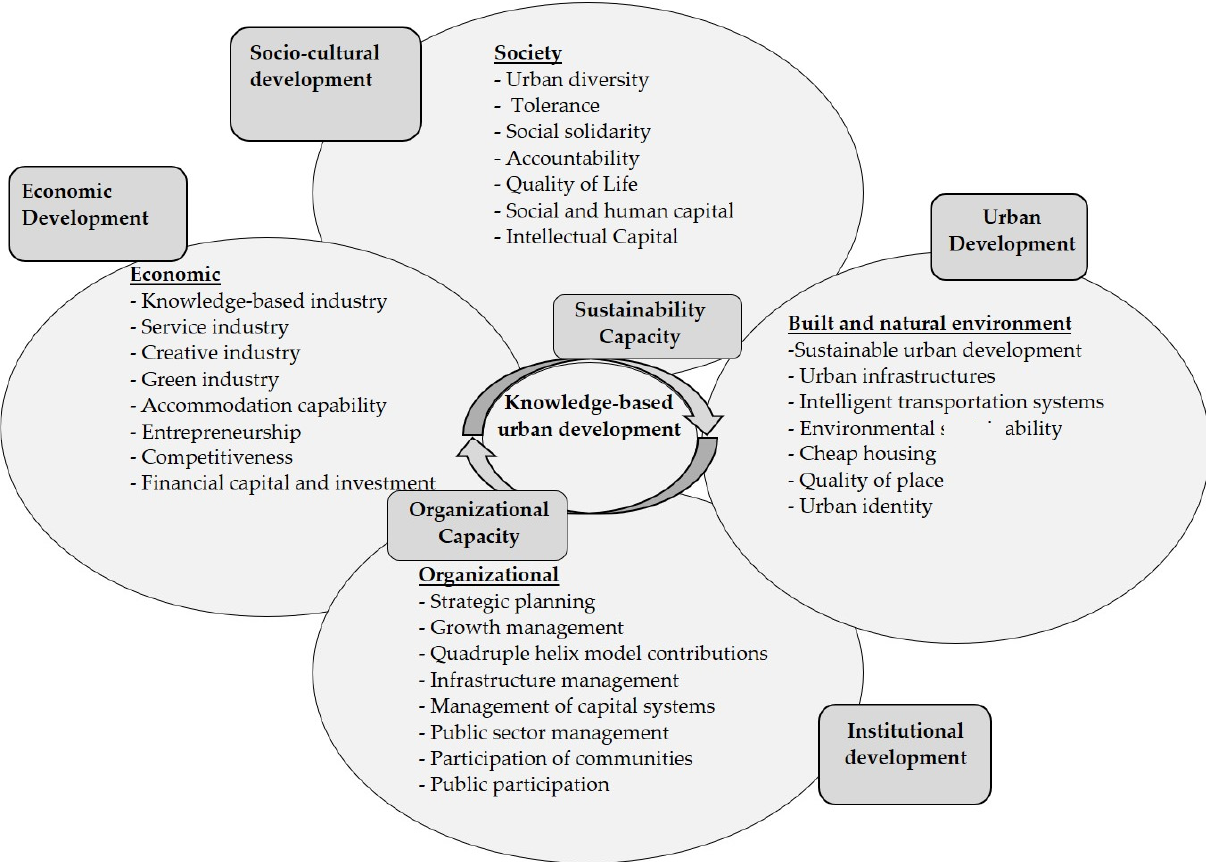
Figure 1. Knowledge-based urban development areas